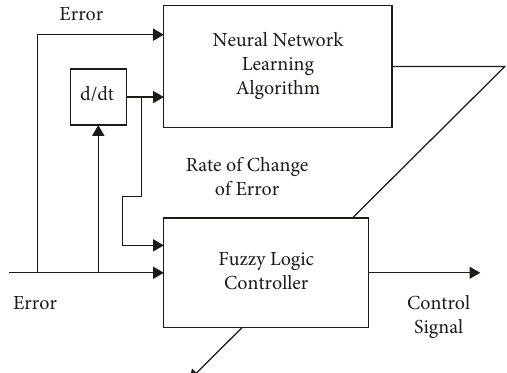
Figure 10: Block diagram of the supervisory controller of the system.